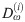
Sample density of the PER mRNA differences, Dω(i), from the time series in Fig 3a. Ω = 50 and the samples taken at one minute intervals (τ = 1/60).The sample density appears normal, justifying the normality approximation of Eq (8). We see that the mean of the changes in PER mRNA every minute is slightly positive and the range is between -4 and 4, as was the case in Fig 3.